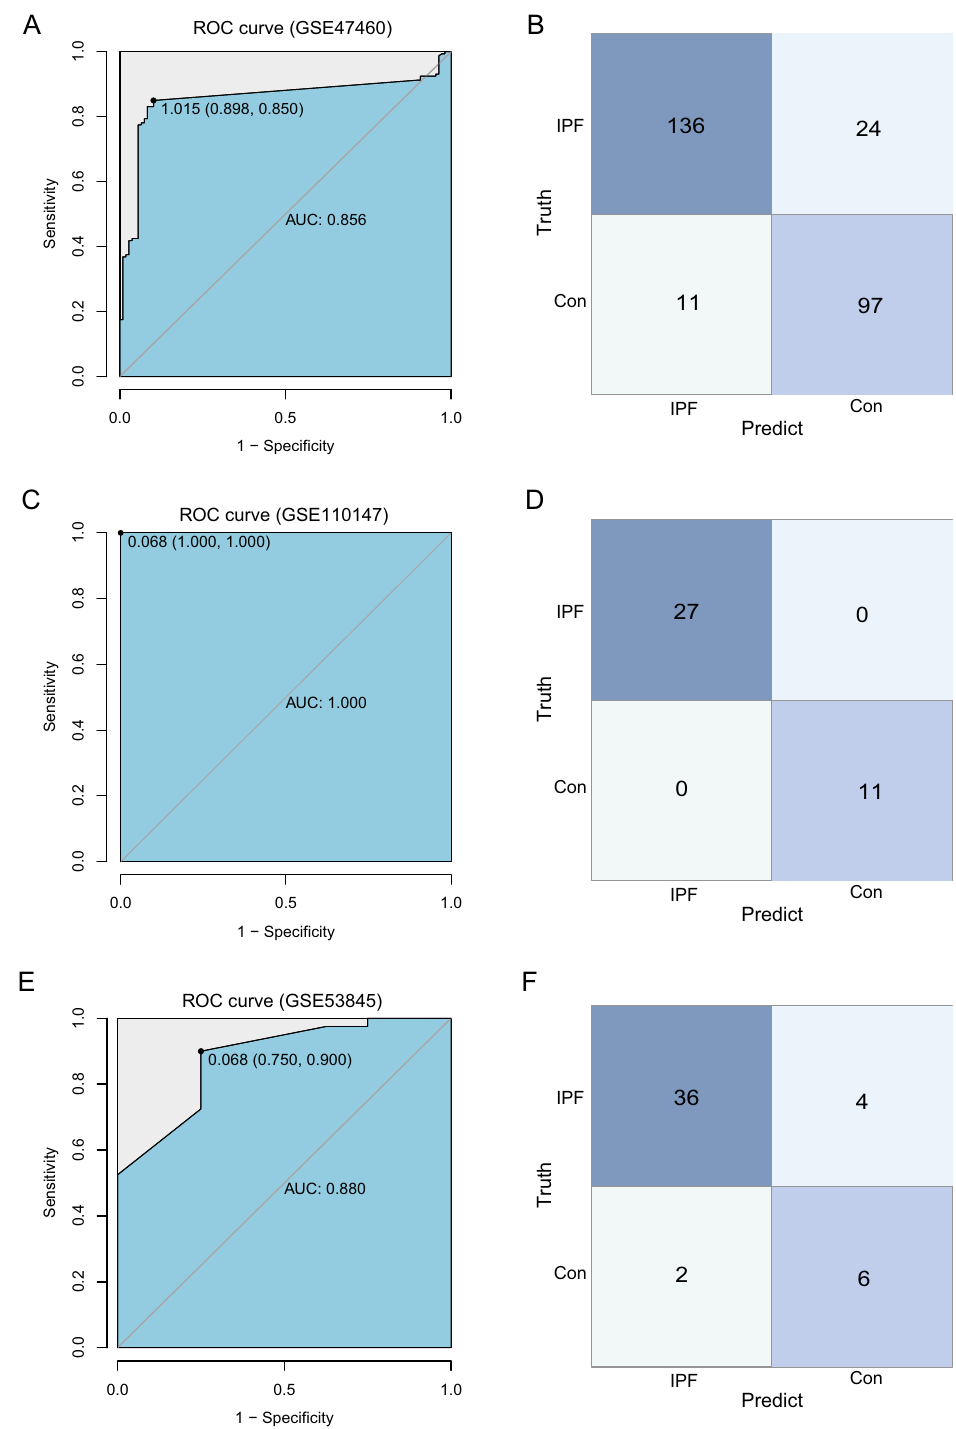
Figure 5. Model accuracy verification. ( A ) Verification of the ROC curve results in GSE47460. The points marked on the ROC curve are the optimal threshold points, and the values in parentheses represent sensitivity and specificity. The AUC value is the area under the ROC curve. ( B ) GSE47460 confusion matrix result. The x-axis represents the predicted results, and the y-axis represents the actual results. ( C ) Verification of the ROC curve results in GSE110147. The points marked on the ROC curve are the optimal threshold points, and the values in parentheses represent sensitivity and specificity. The AUC value is the area under the ROC curve. ( D ) GSE110147 confusion matrix result. The x-axis represents the predicted results, and the y-axis represents the actual results. ( E ) Verification of the ROC curve results in GSE53845. The points marked on the ROC curve are the optimal threshold points, and the values in parentheses represent sensitivity and specificity. The AUC value is the area under the ROC curve. ( F ) GSE53845 confusion matrix result. The x-axis represents the predicted results, and the y-axis represents the actual